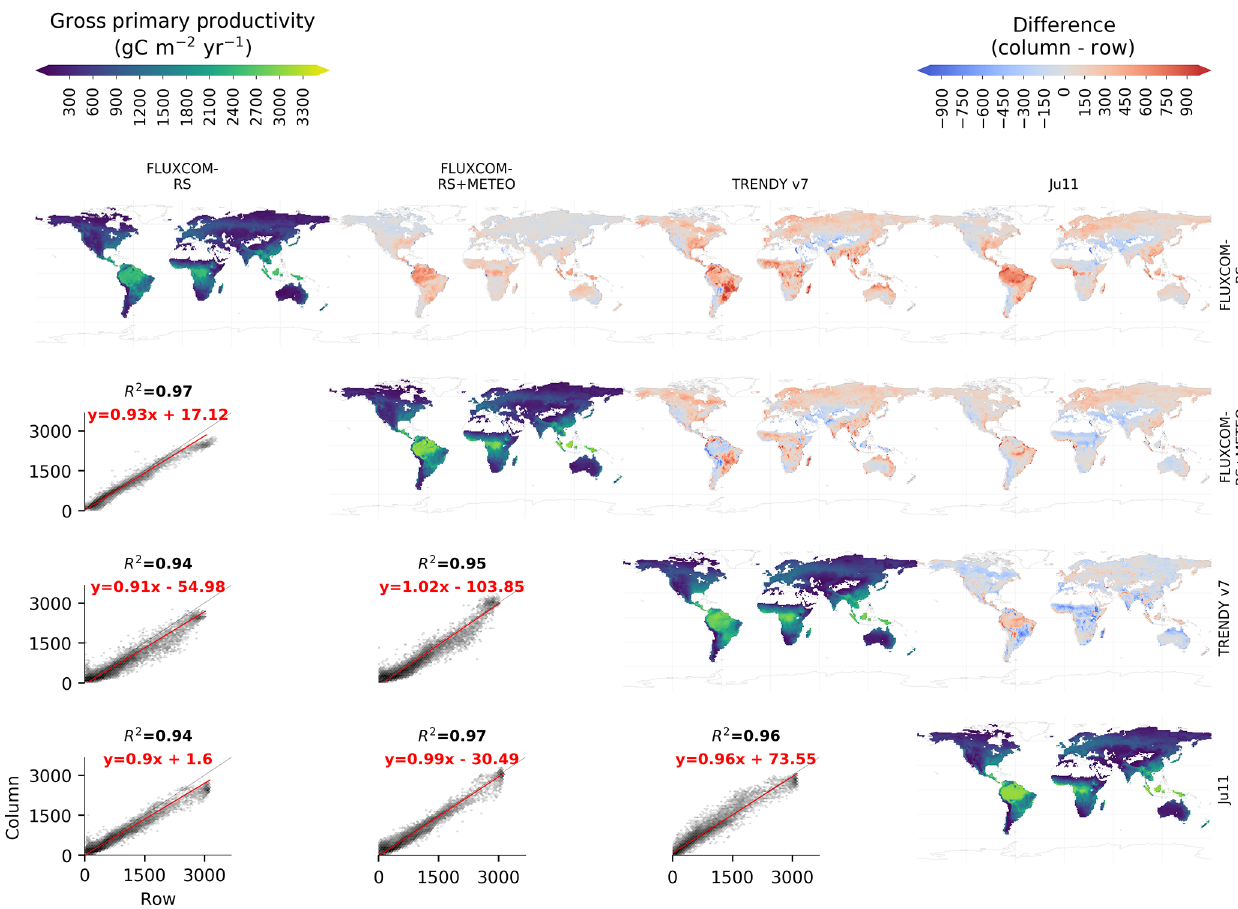
Figure 2. Comparisons of mean annual GPP at 1 ◦ spatial resolution for the period 2008–2010 of FLUXCOM ensemble products with Ju11 and the mean of 16 TRENDY models. The diagonal denotes maps of mean annual GPP. Above the diagonal denotes maps of GPP differences (product along column – product along row). Below the diagonal denotes the 1 : 1 regression where the shading shows point density. The red line and equations show the best-fit line from total least-squares